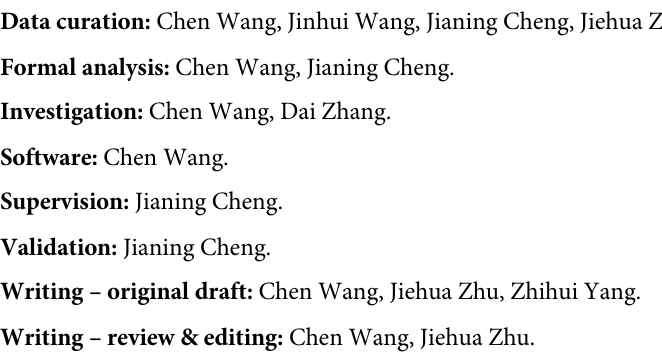
S2 Table. Expression levels of senescence- and oxidative stress-associated genes. The expression of Actin , SEN4 , SAG12 and DHAR1 in N . benthamiana leaves injected with empty vector and Agrobacterium containing AsCEP50 . S3 Table. Quantitative data for senescence. Lesion length and width of N . benthamiana leaves injected with empty vector and Agrobacterium containing AsCEP50 . S4 Table. Primer amplification efficiency. S5 Table. Primers used for this